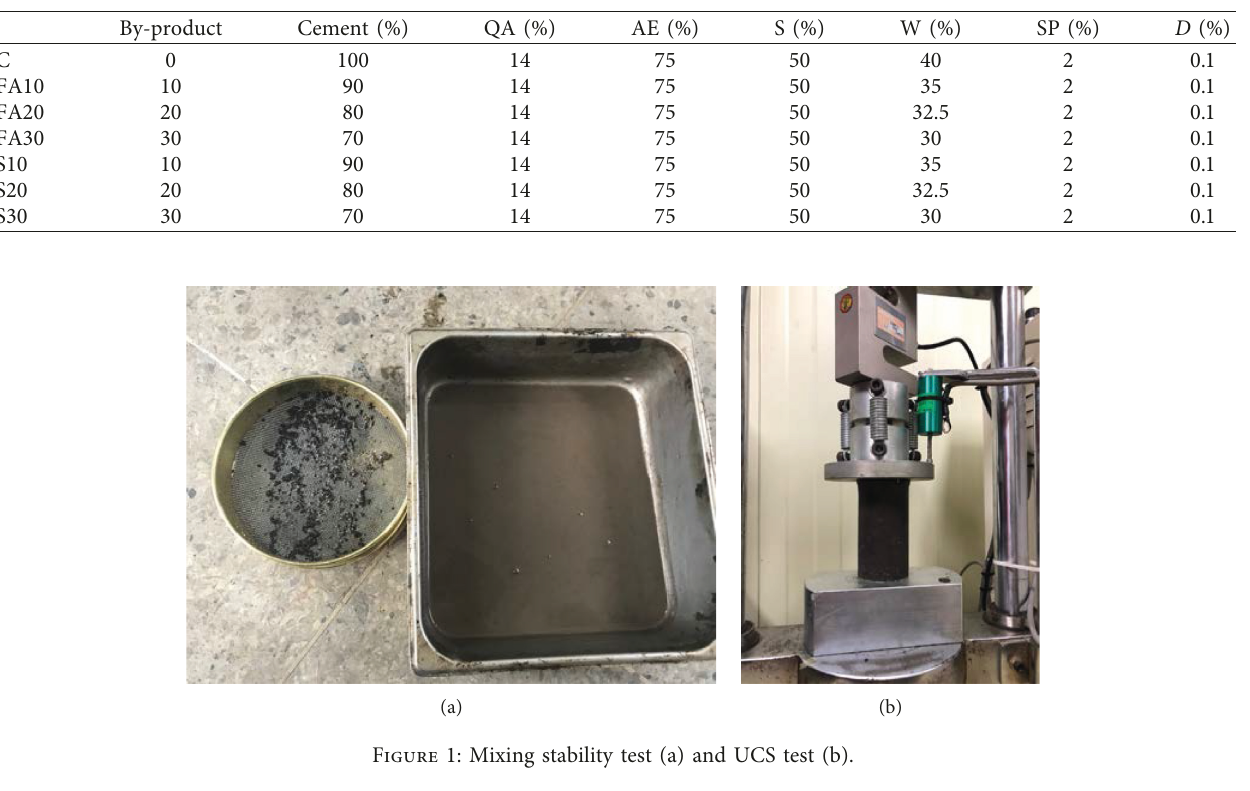
Table 3: Mix design (by weight of cement/by weight of cement+by-product).